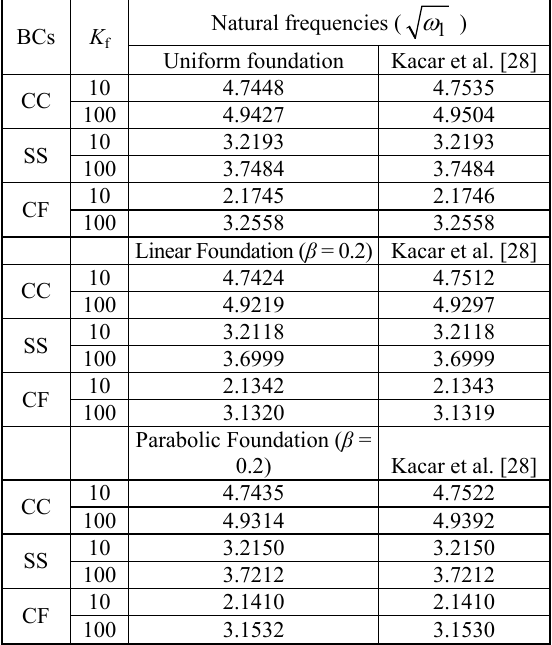
Table 2. Validation of adopted formulation and solution